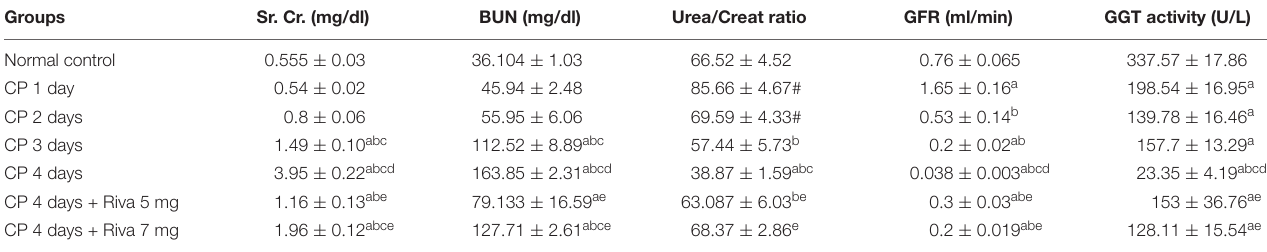
TABLE 1 | Effect of cisplatin (CP) with or without rivaroxaban (Riva) on renal function tests. Groups Sr. Cr. (mg/dl) BUN (mg/dl) Urea/Creat ratio GFR (ml/min) GGT activity (U/L) Normal control